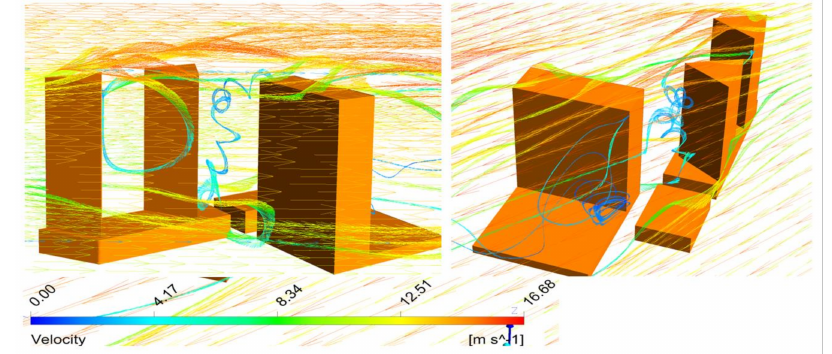
Figure 19. Streamlines of wind speed in the velocity scale for two